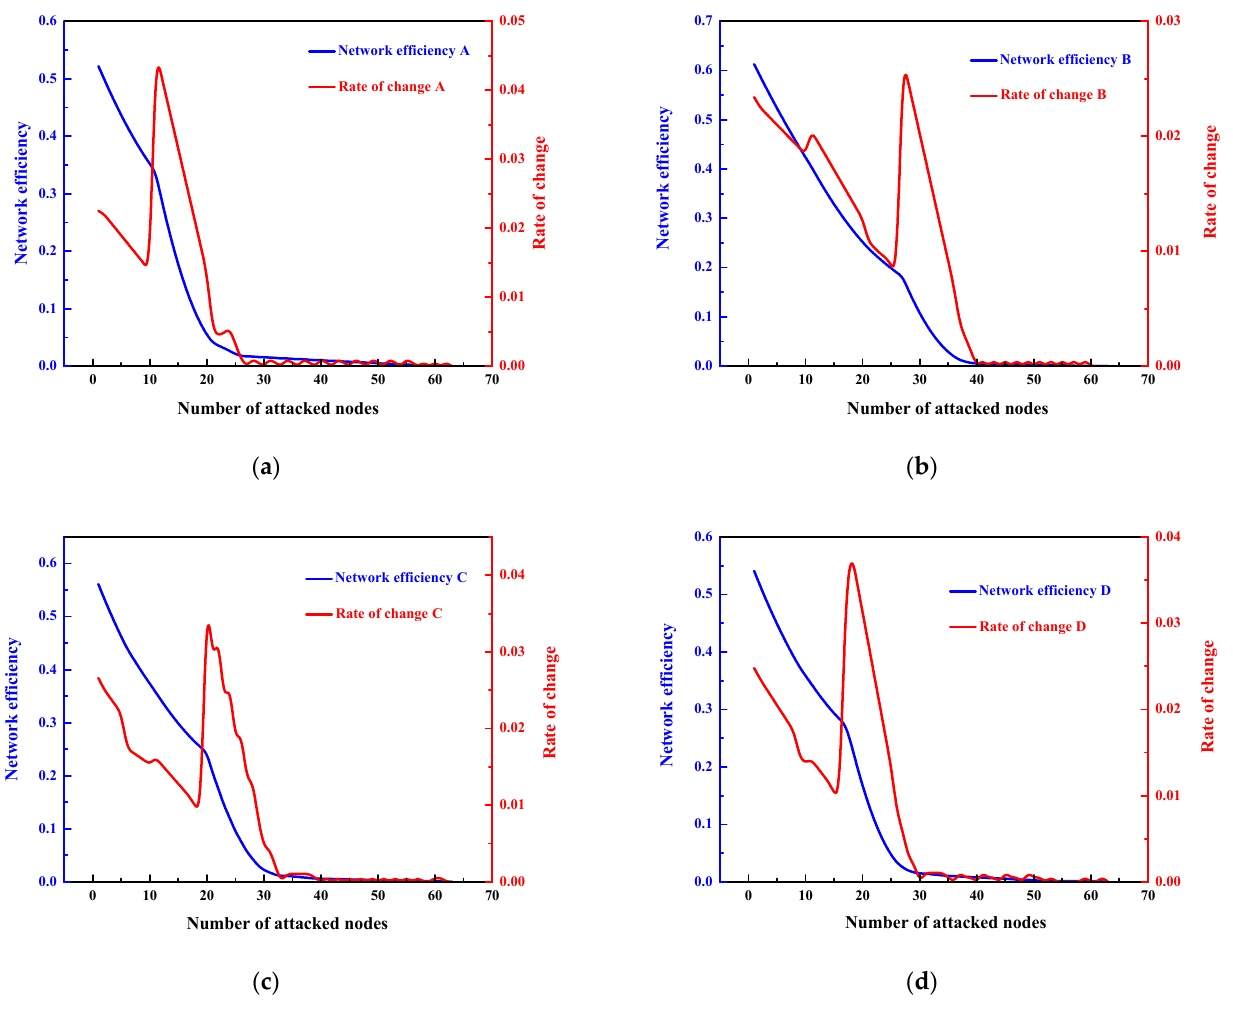
Figure 6. Graph of network efficiency and rate of change under deliberate attack. ( a ) Network A; ( b ) Network B; ( c ) Network C; ( d ) Network D.